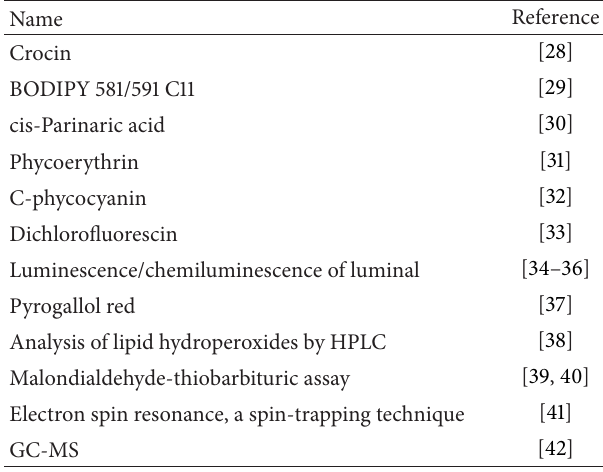
Table 1: List of indicator molecule with analysis system/model system for assessing peroxyl